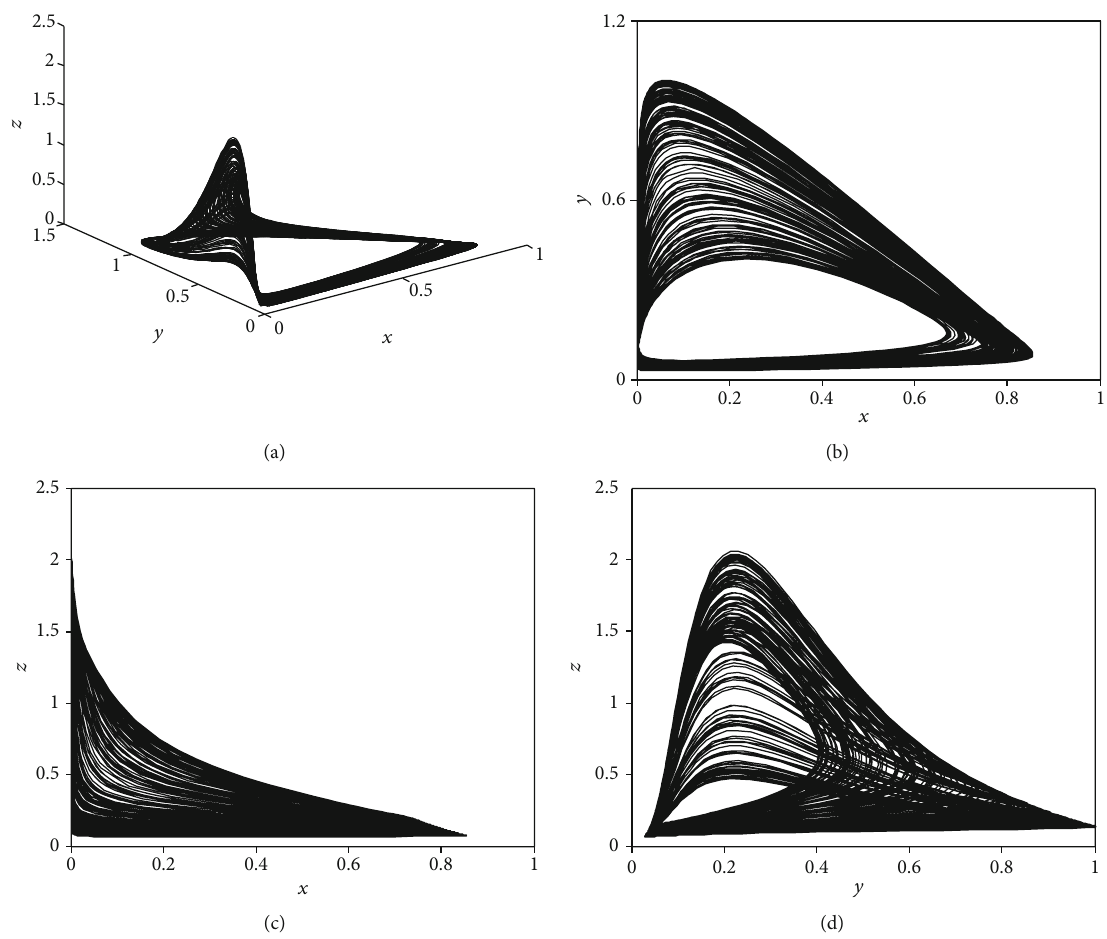
Figure 9: (a) The trajectory of system (4) approaches a chaotic attractor using the dataset given by (90), while their projection on xy , xz , and yz planes are shown in (b), (c), and (d),